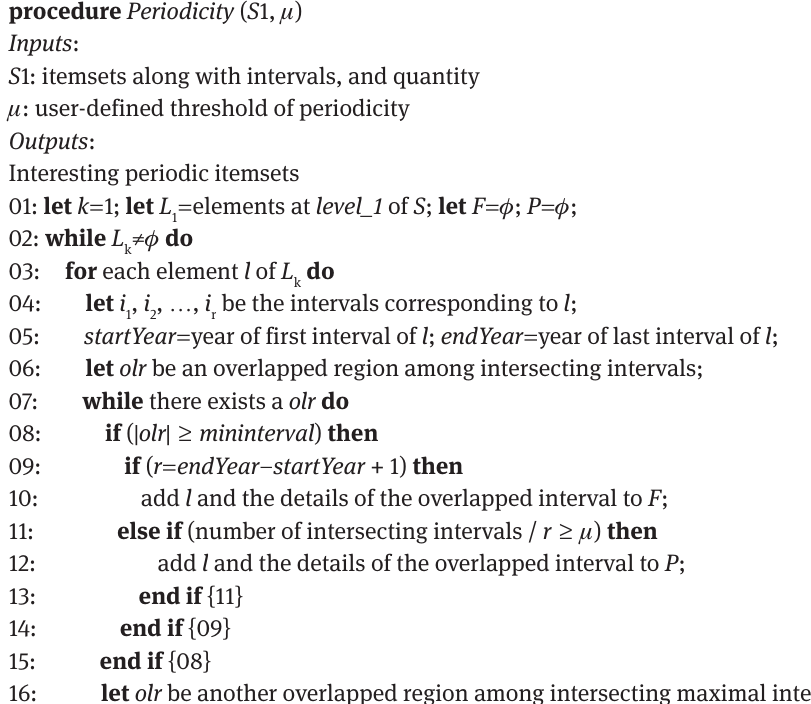
Algorithm 3. Determining periodicity of